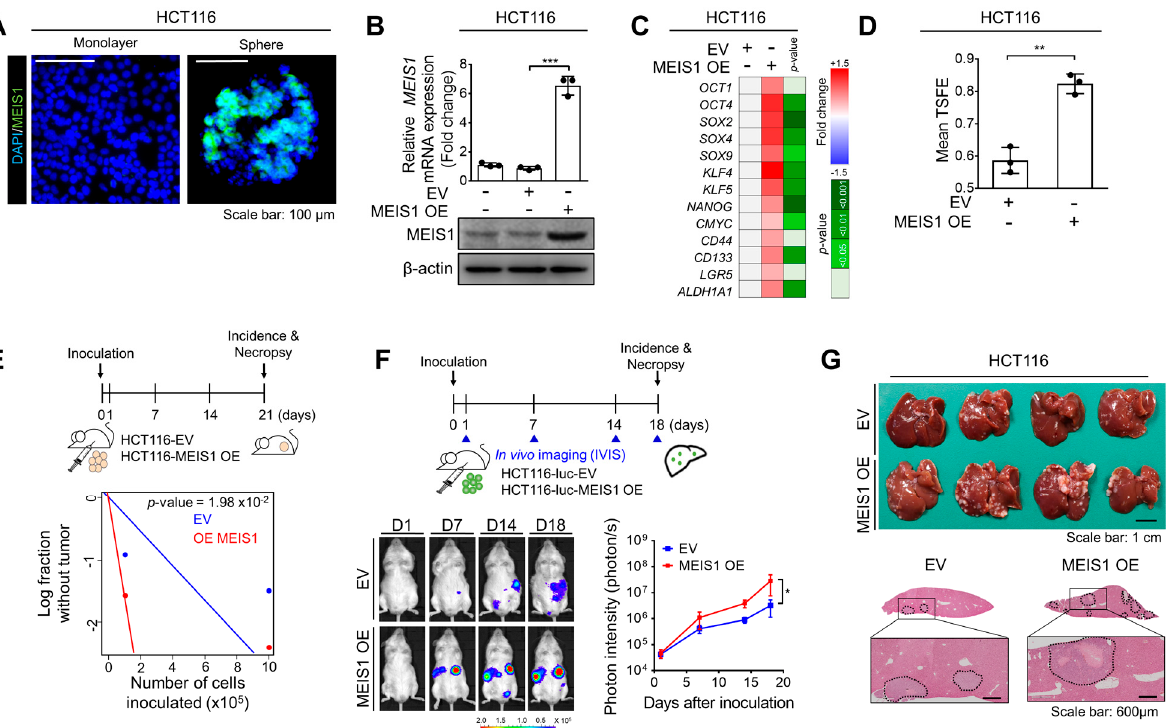
Figure 4. Functional validation of the effects of MEIS1 overexpression on CRC stemness and metastasis. ( A ) Immunofluo- rescence assay showing the increased MEIS1 protein level in spheres compared with bulk cells. ( B ) Validation of mRNA and protein levels in MEIS1-OE cells. ( C ) RT − qPCR confirming the global increases in stemness-related gene expression levels by MEIS1-OE. ( D ) Sphere formation assay comparing self-renewal ability between MEIS1-OE and control cells. ( E ) In vivo LDA comparing the effect of MEIS1-OE on the self-renewal ability of CSCs. ( F , G ) Mouse model established by splenic injection comparing metastatic potential between MEIS1-OE and control cells. The extent of liver metastasis was monitored by ( F ) visualizing luciferase activity and ( G ) definitive necropsy. Representative images of gross anatomy and H&E-stained liver tissue. ** and *** indicate p < 0.05, p < 0.01, and p < 0.001, respectively. CTRL, control; EV, empty vector; OE, overexpression.